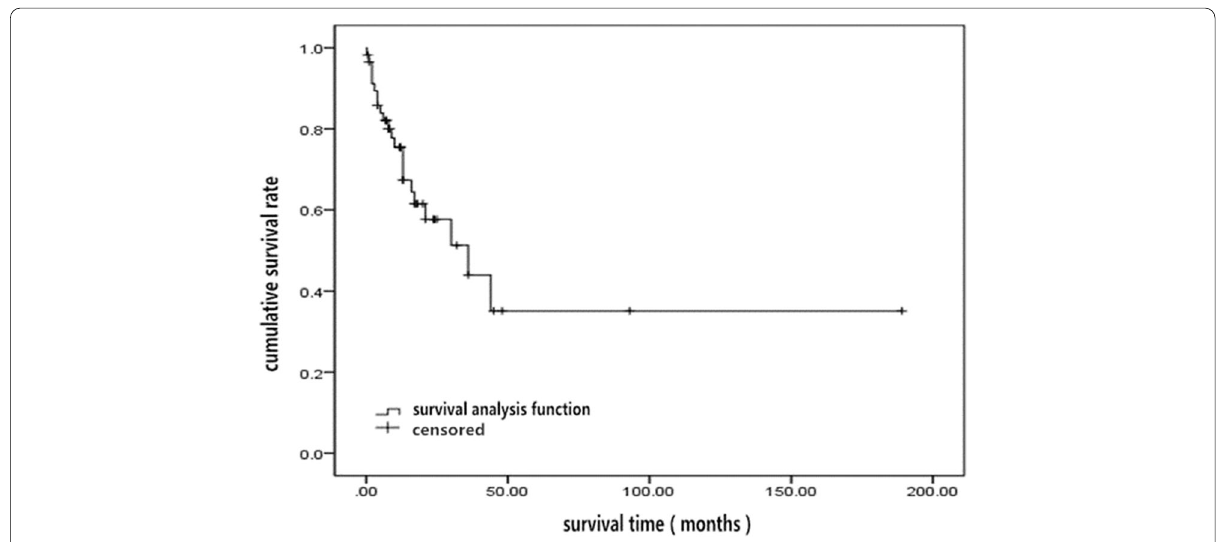
Fig. 7 Median survival time of patients with gallbladder MiNENs ( n